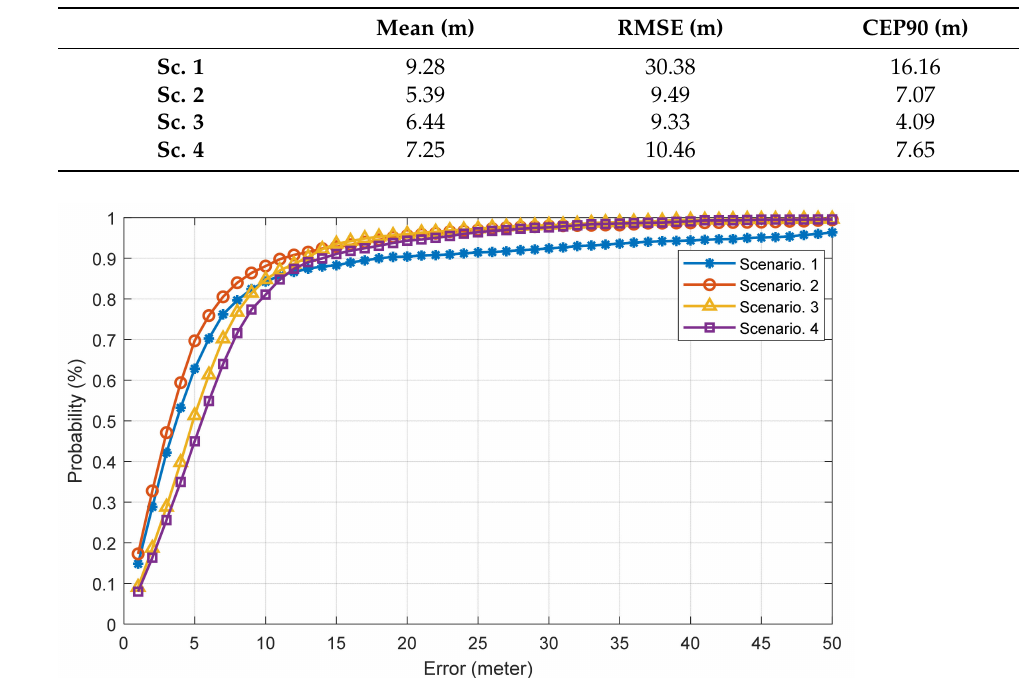
Figure 16. Cumulative distribution function for scenarios